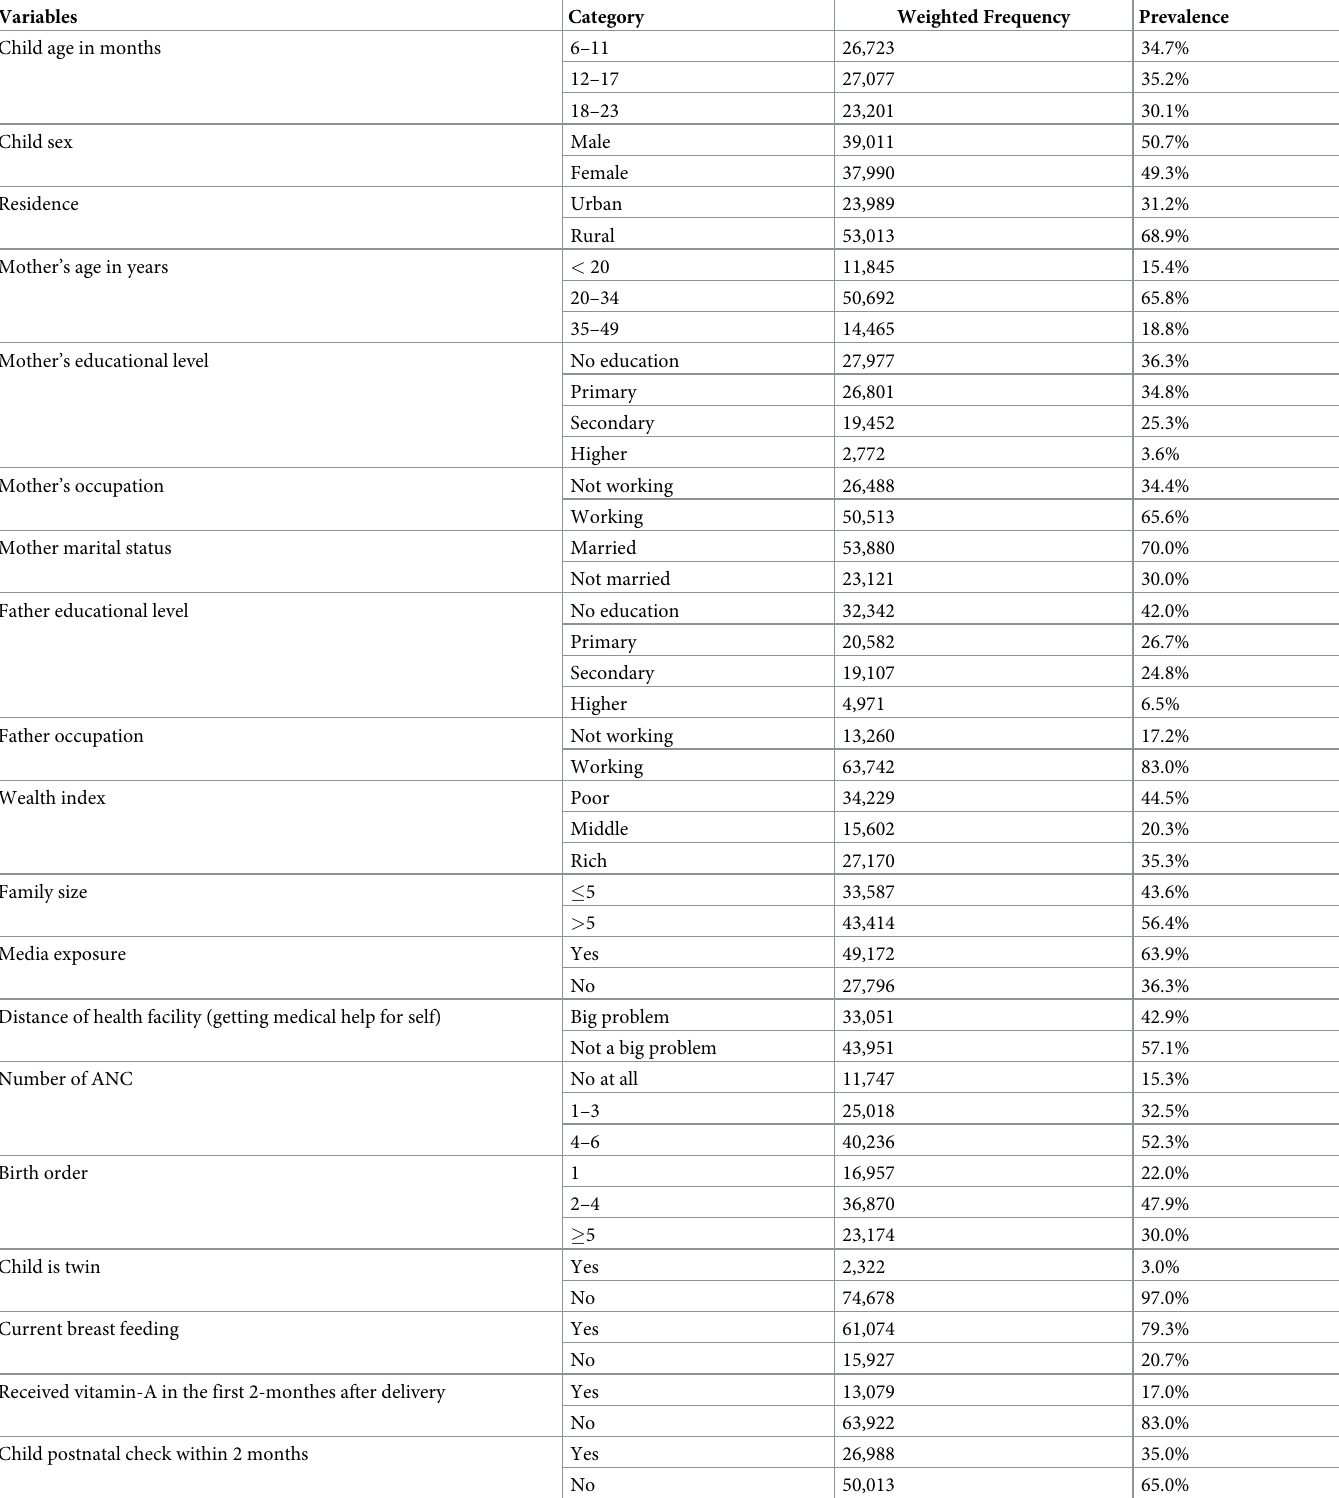
Table 1. Socio-demographic characteristics of the children aged 6–23 months and respondents, demographic and health survey of sub-Saharan Africa (n =